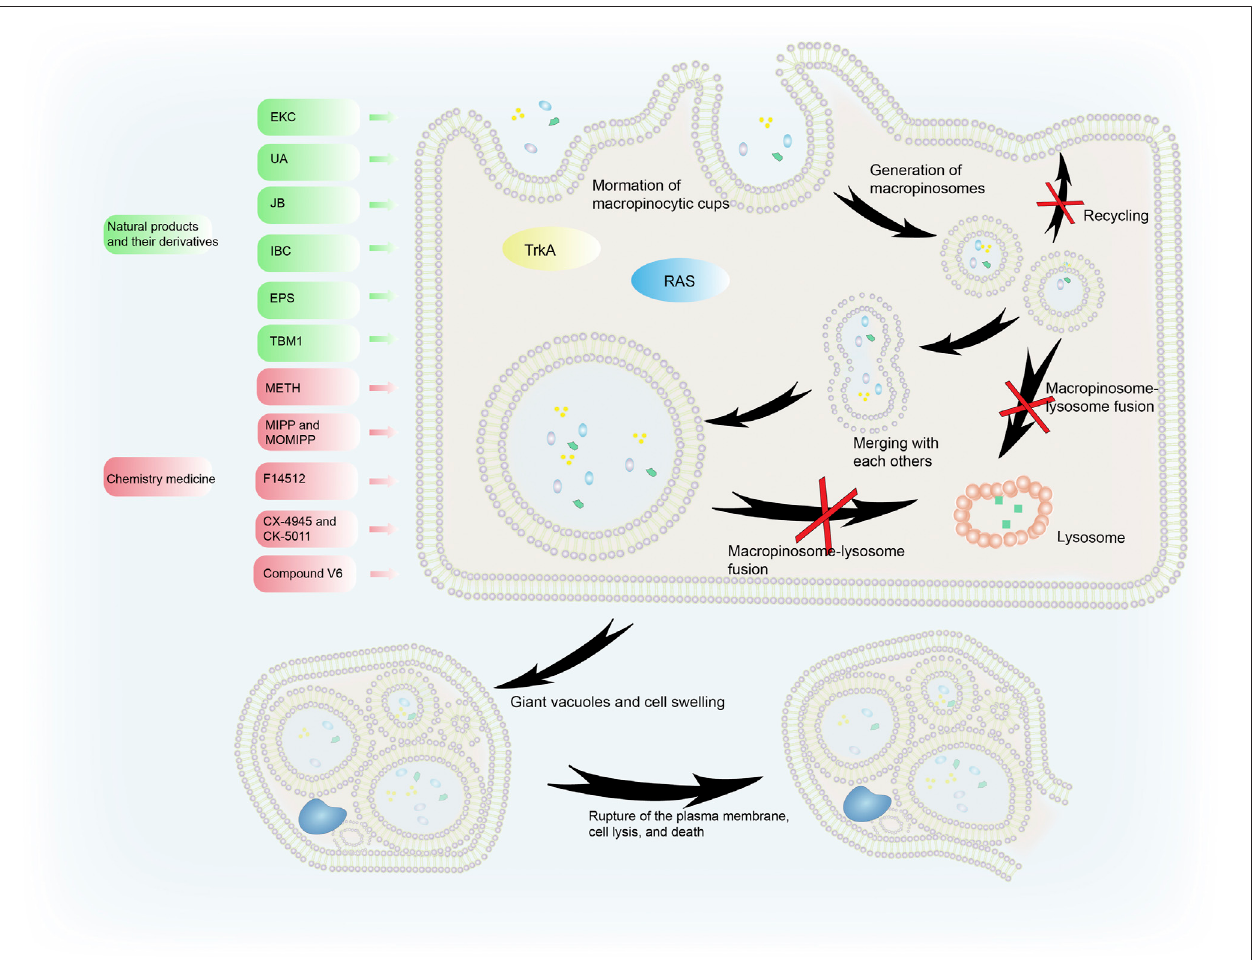
FIGURE 3 | The process of methuosis. Several compounds induce methuosis. Over-activated RAS gene and TrkA can induce methuosis. Macropinosomes graduallymergetoformlargevacuoleswhicheventuallyleadstocelldeath.Naturalproductsandtheirderivatives(suchasEKC,UA,IBC,andJB)caninducemethuosis, as can synthetic compounds such as METH, F14512, CX-4945, and